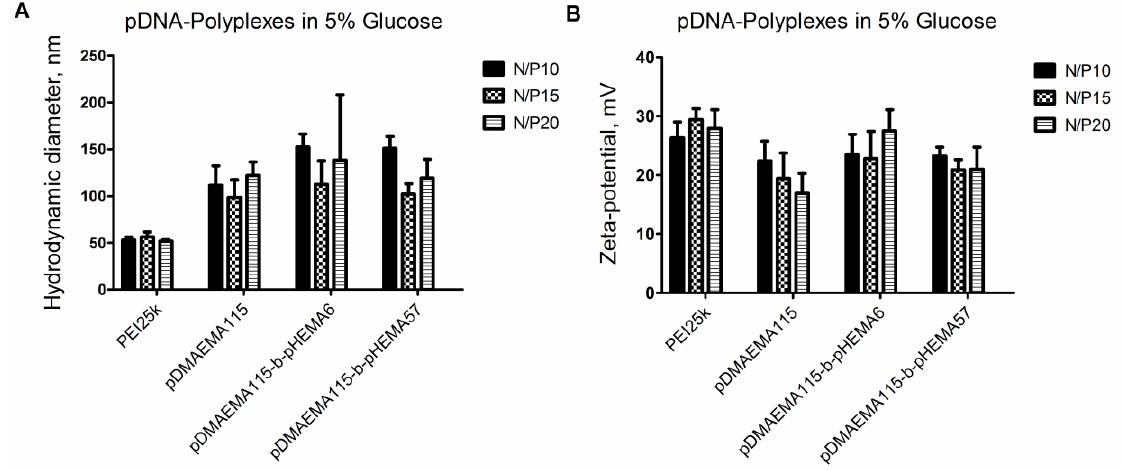
derivatives in isotonic glucose. 115